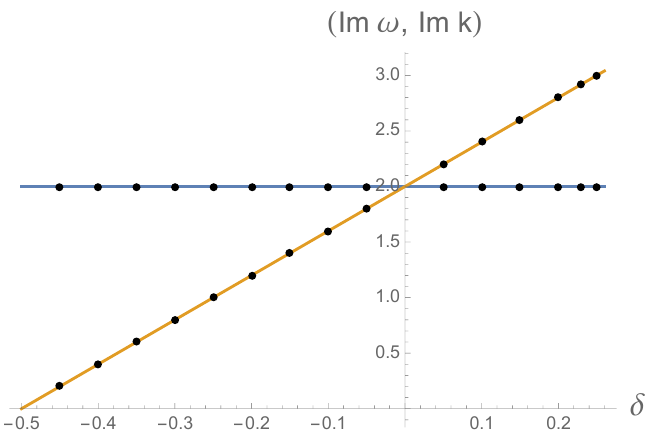
Figure 1 . The plot shows the numerical fitting for pole-skipping Im ω (blue) and Im k (orange) as a function of δ . The solid lines corresponds to the analytic curve ( Im ω, Im k ) = (2 , 2(1 + 2 δ )) while the dots are our numerical results for various δ